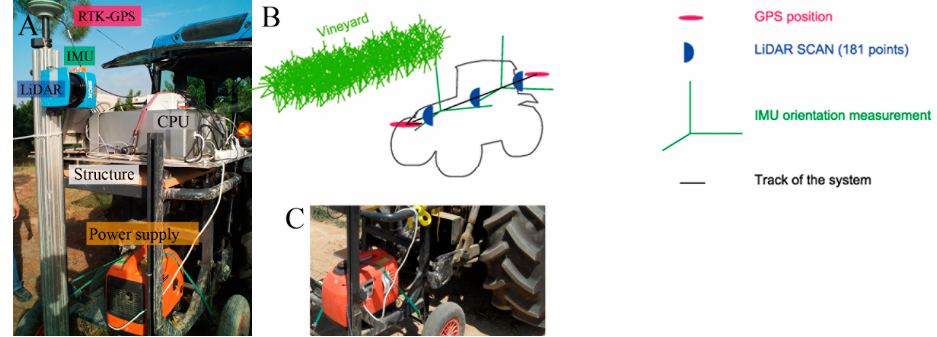
Figure 2. Image of the different sensors ( A ); interaction of the MTLS components ( B ); and connection to the three-point hitch of the tractor ( C